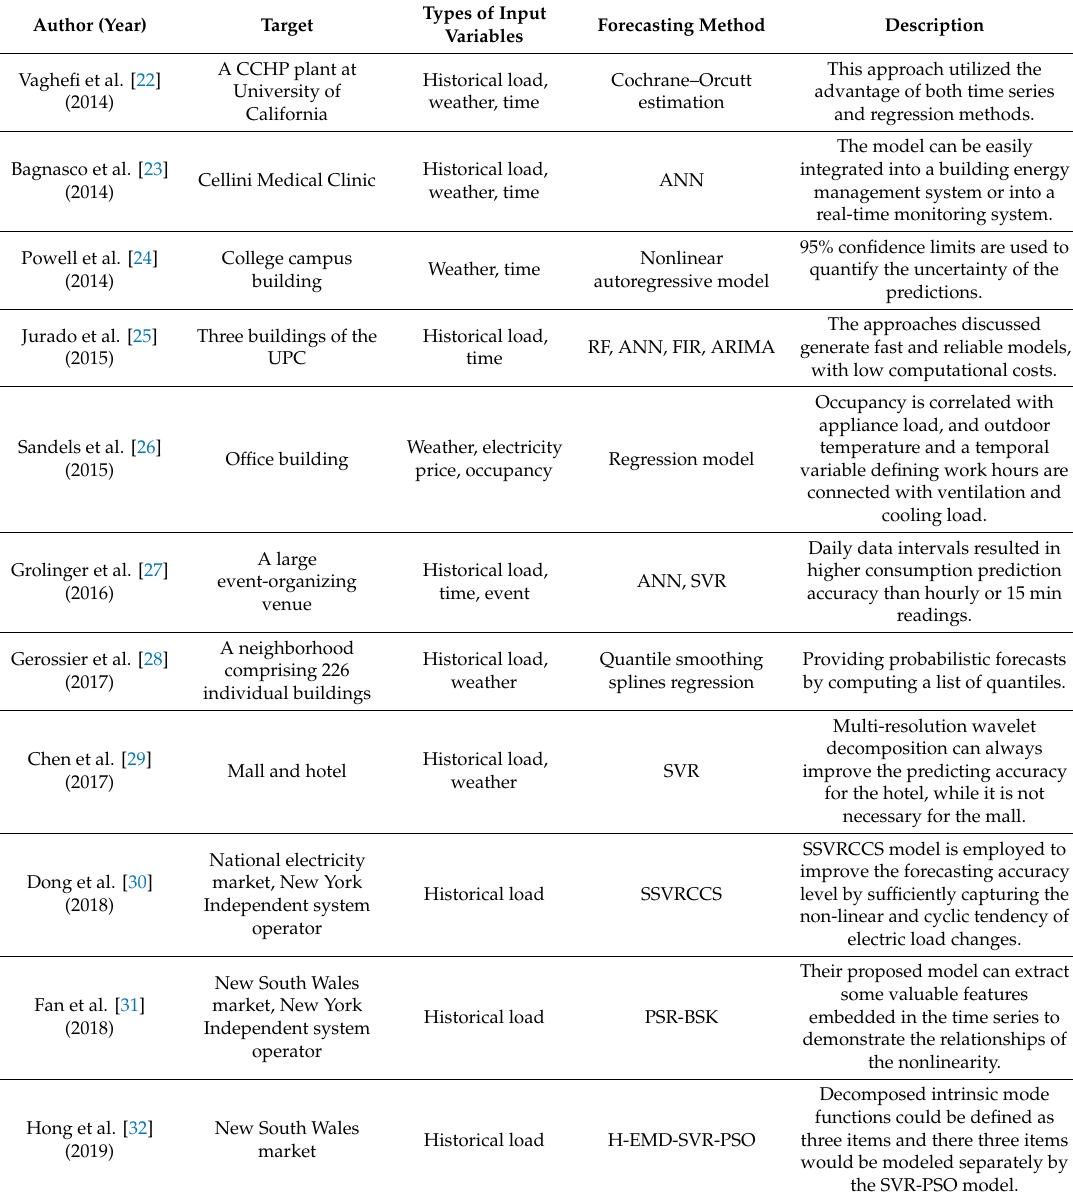
Table 1. Summary of several approaches for short-term load